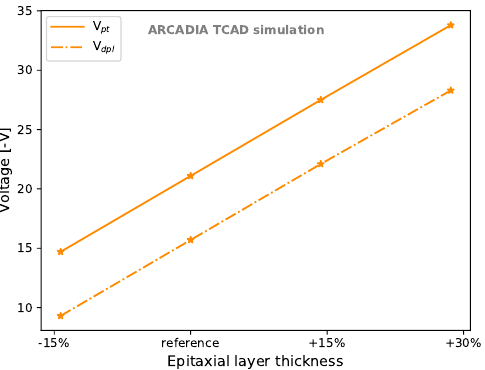
Figure A1. V dpl and V pt as a function of the epitaxial layer thickness, expressed as percentage variation with respect to the reference